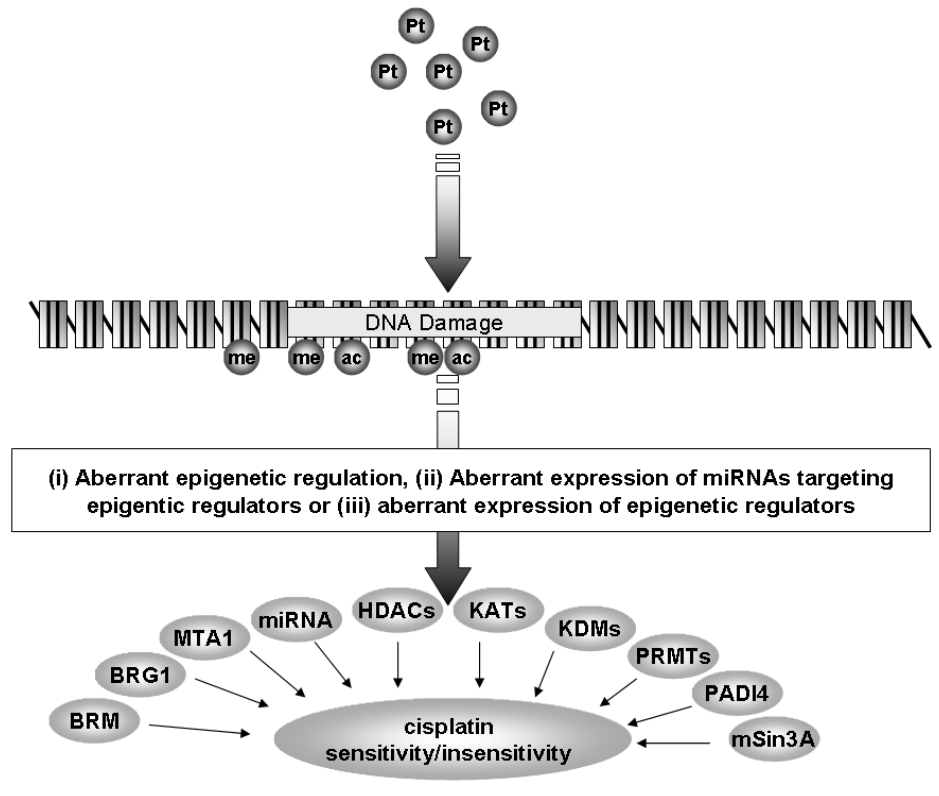
Figure 1. Epigenetics underpinning cisplatin resistance in NSCLC. Diagram summarizing the available evidence linking aberrant epigenetics in the forms of altered gene regulation, or how alterations to the levels of epigenetic modifiers may affect NSCLC sensitivity to cisplatin